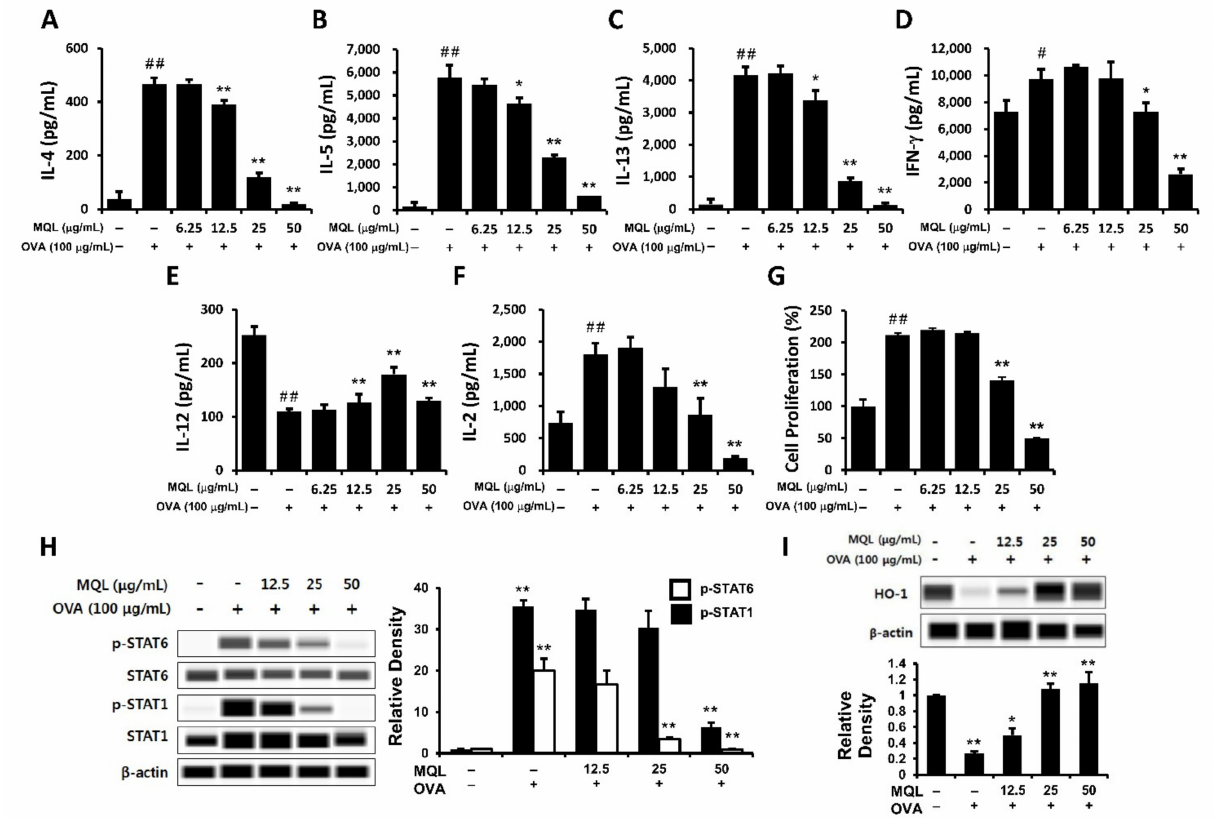
Figure 2. Immunomodulatory effects of MQL on splenocytes of BALB/c mice immunized by OVA. Allergic immune responses in BALB/c mice were induced by i.p. injection of OVA (10 µ g) with alum (1 mg) on days 7 and 14. Splenocytes were seeded to 5 × 10 6 cells/mL and cultured in the presence or absence of OVA (100 µ g/mL) and MQL for 72 h. ( A ) IL-4, ( B ) IL-5, ( C ) IL-13, ( D ) IFN- γ , ( E ) IL-12, and ( F ) IL-2 cytokines in culture supernatant of splenocytes were measured using ELISA. ( G ) Cell proliferation was measured using MTT assay. ( H ) STAT1 and STAT6 phosphorylation and ( I ) HO-1 expression were detected using Western blot. Results are shown as mean ± SD. # p < 0.05, ## p < 0.01, between the non-treated and OVA-treated groups, * p < 0.05, ** p < 0.01, between the MQL-treated and OVA-treated